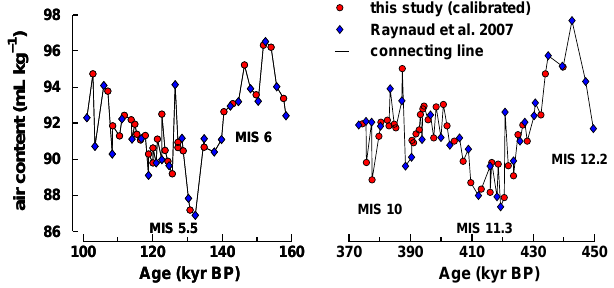
Figure 6. Comparison of our calibrated air content measurements from the Dome C core with published results from the same